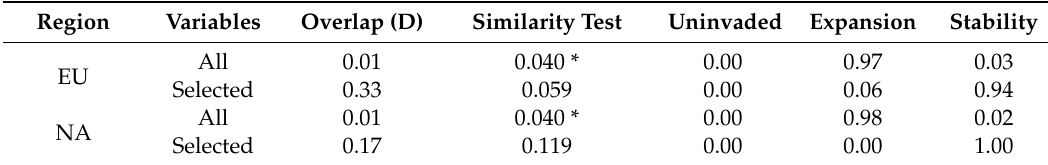
Table A2. Summary of p values for the niche test of Asian long-horned beetle between invasive range in Europe (EU) and North America (NA) and native range in Asia using all and the selected climatic variables (2 → 1). Significant p values ( α = 0.05) are represented by *.